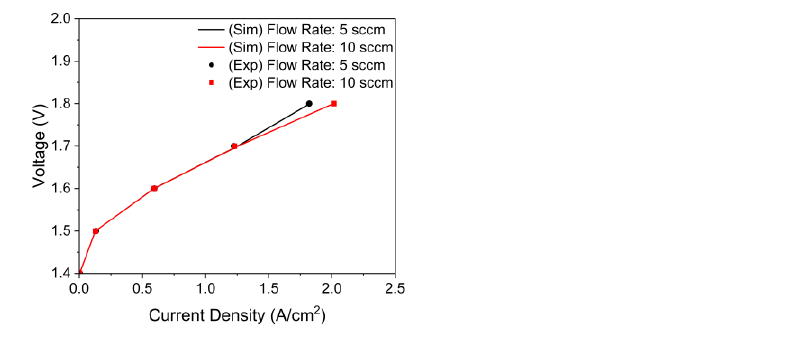
Figure 6. Comparison of polarization curves between simulation and experimental data by inlet flow rate ( W Ch : 2 mm, W Rib : 2 mm, H Ch : 2 mm, ε : 0.75, K : 30.2 × 10 −12 m 2 , θ : 30°, T in : 328.15 K, T cell : 328.15 K and 𝑔 : z+)